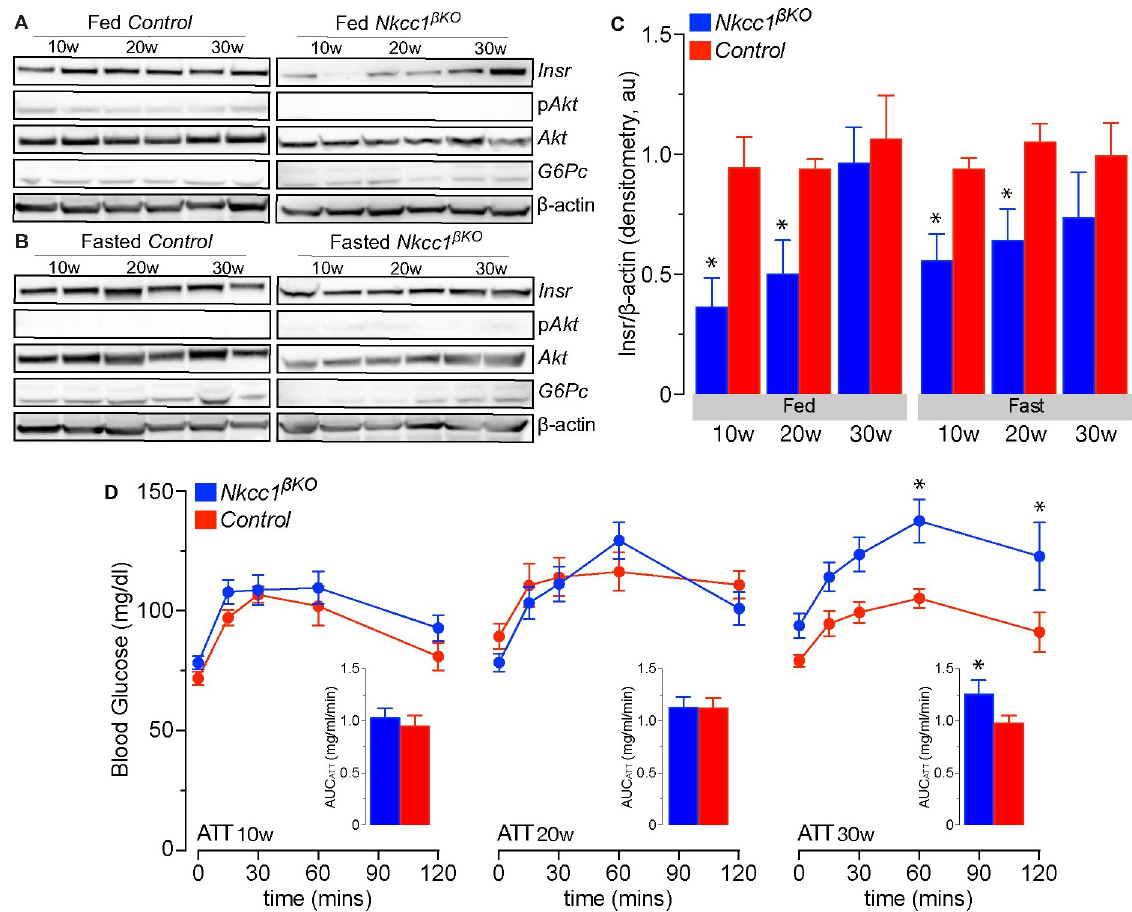
Fig 3. Hepatic insulin receptor expression, signaling and de novo gluconeogenesis in Nkcc1 β KO mice. A, B . Expression pattern of insulin receptors ( Insr , 95kDa), Akt (60kDa) and G6Pc (40kDa) and phospho-activation of Akt (p Akt ) in liver extracts of 10w, 20w and 30w Nkcc1 β KO and control mice ( Ins1 Cre ) fed (A) or fasted 16h (B). Shown are representative immunoblots loaded to represent 2 mice ( n = 3–4 per genotype, age and condition). As loading control, we used β -actin (45kDa). C . Semi-quantitative densitometry analysis of hepatic Insr expression levels relative to β -actin expressed in arbitrary units ( au ). Shown are the mean ± SEM of 3 independent blots corresponding to 3 male mice of the indicated genotypes, ages and condition ( � p < 0.05). D . Blood glucose excursions (mg/dl) during alanine tolerance tests (ATT) performed in 16h fasted Nkcc1 β KO and control mice ( Ins1 Cre ) at the indicated ages (mean ± SEM, n = 9–10, � p < 0.05). The areas under each curve (mg/ml/ min) are indicated as insets in